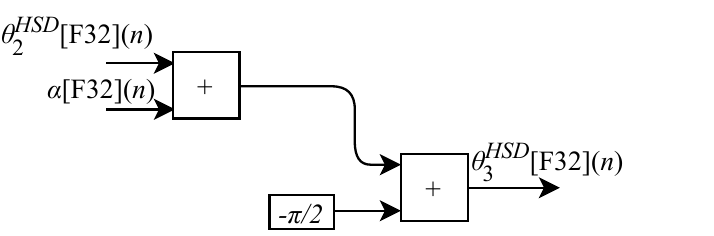
[ F 32 ]( n ) angular position 3